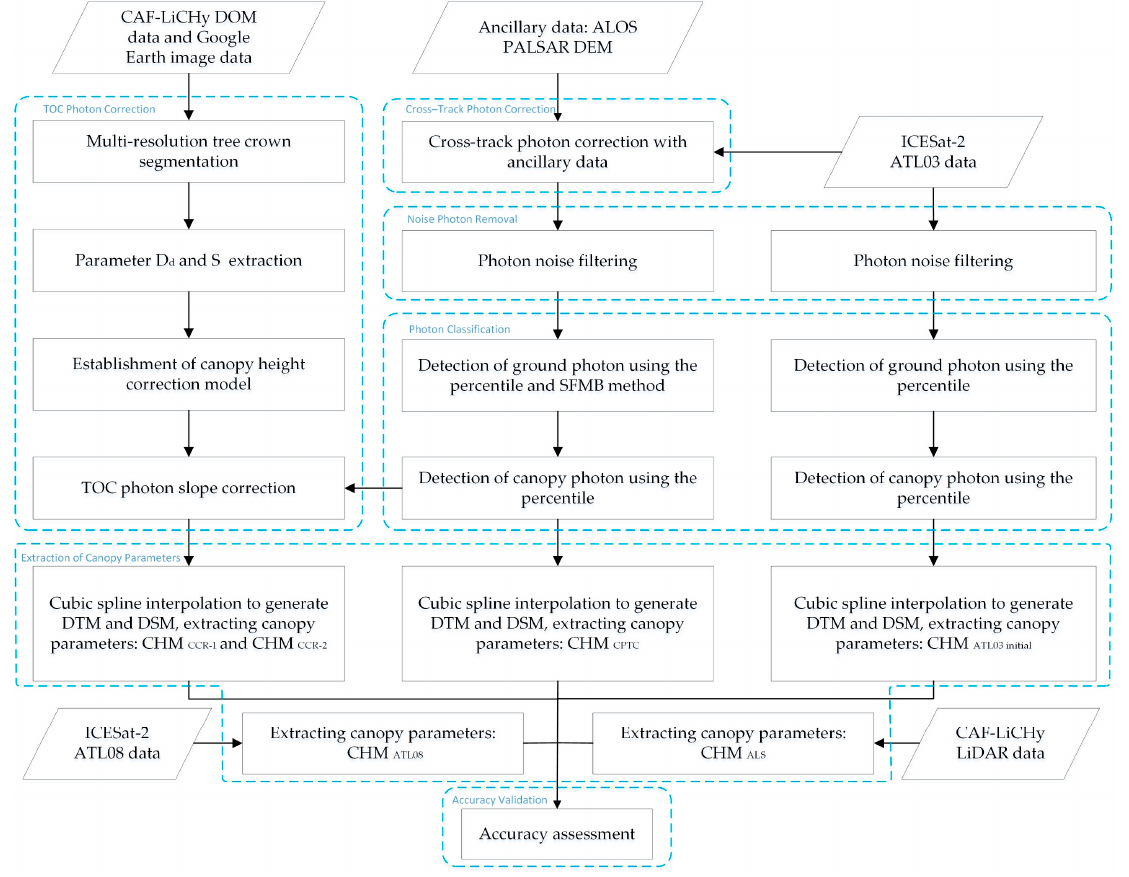
Figure 3. Methodology flowchart.